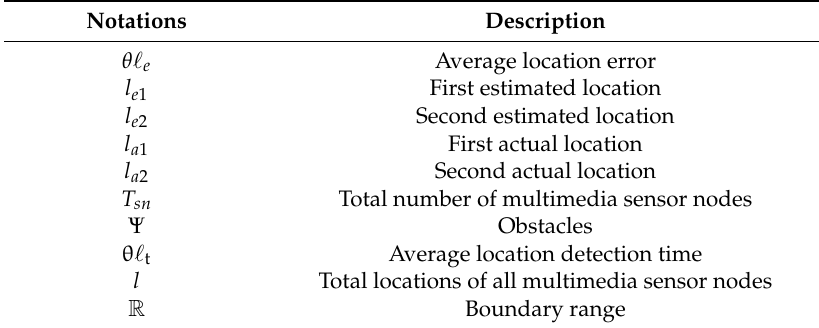
Table 3. Notations and their description.